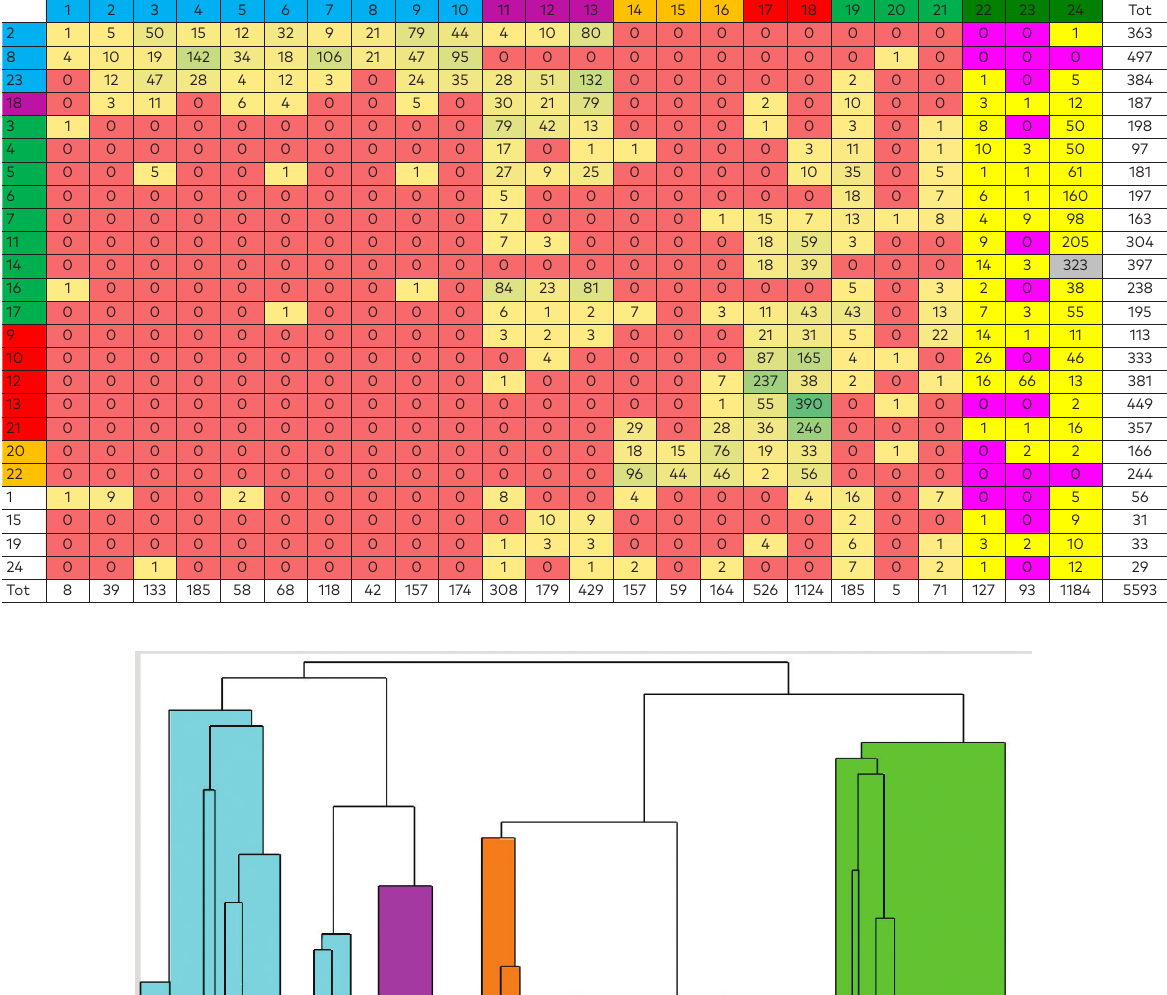
Table 1. Comparative matrix between the 24 groups obtained by Finite Mixture Model classification (rows) and the 24 groups by the modified version of TWINSPAN (columns). Colors of the margins (groups) indicate membership to the clusters. Within the matrix, the red color indicates no correspondence among the groups. An increasing correspondence is highlighted by a color gradient from yellow to dark green.